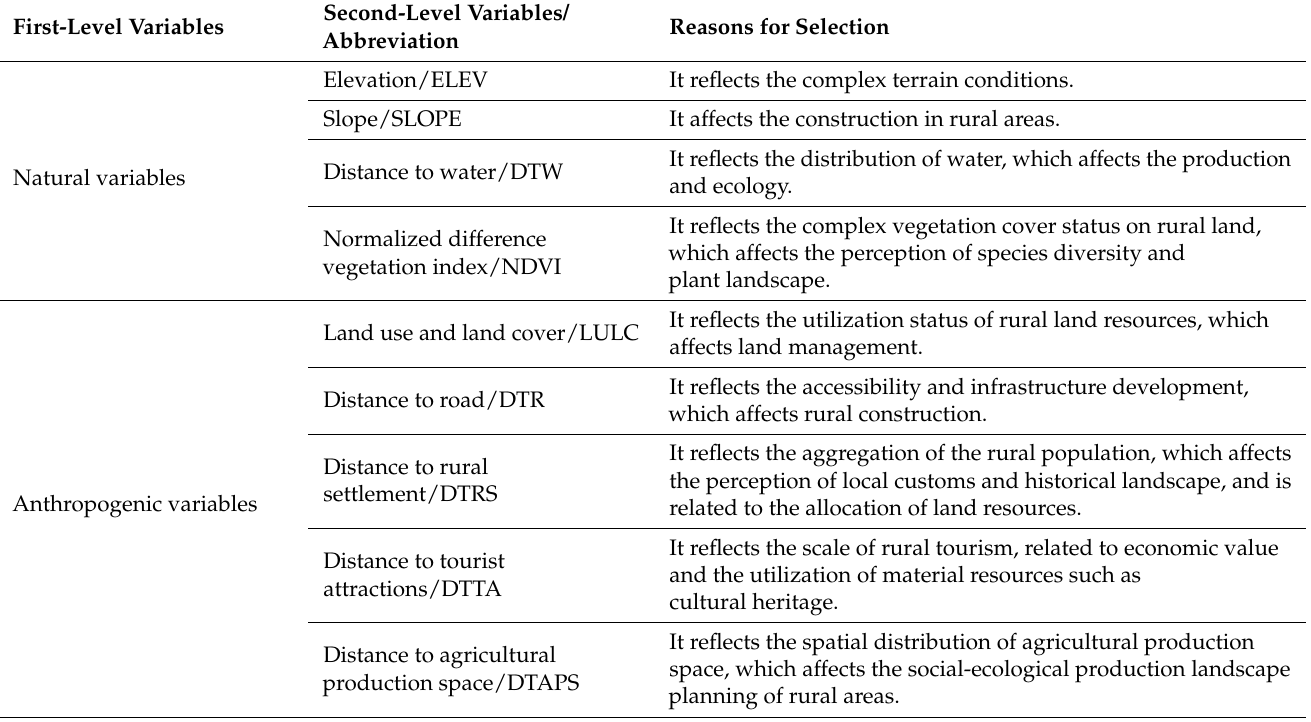
Table 2. Environmental raster datasets for the SolVES model in rural